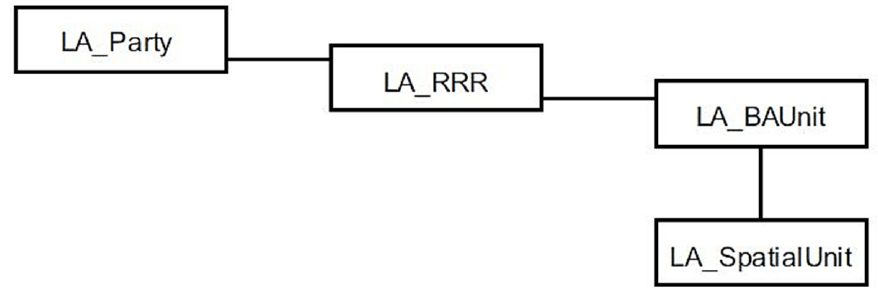
Figure 1. The four basic classes of the core land administration domain model (LADM) ([11], p. 9).